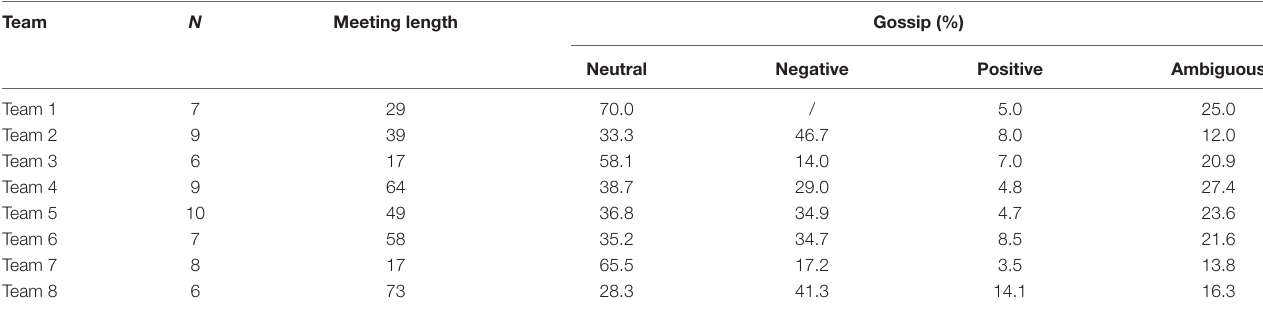
TABLE 2 | Distribution of gossip events per team